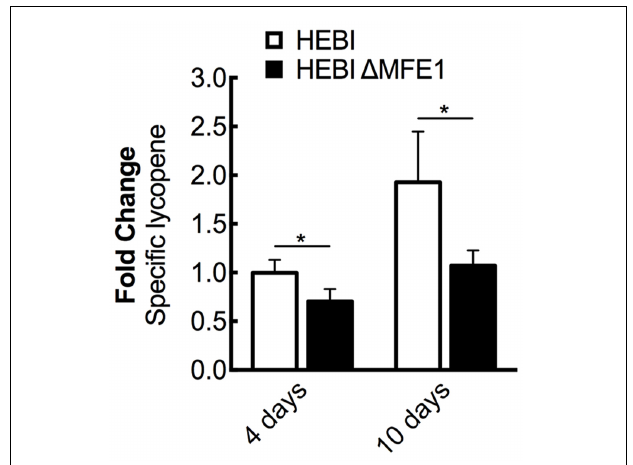
FIGURE 3 | The effect of β -oxidation on lycopene production in Y. lipolytica PO1f. Relative specific lycopene content of strains with and without intact β -oxidation at 4 and 10 days of culture time. β -oxidation was disrupted by knockout of MFE1 . Strains were grown for 4 and 10 days in 25 mL of YPD10 at 30 ◦ C in baffled shake flasks. Bars and error bars represent the mean and standard deviation, respectively, of biological triplicates. Statistical significance from the HEBI strain is indicated by “ ∗ ”. At 4 days, the HEBI strain produced 2.8 ± 0.3 mg lycopene/g